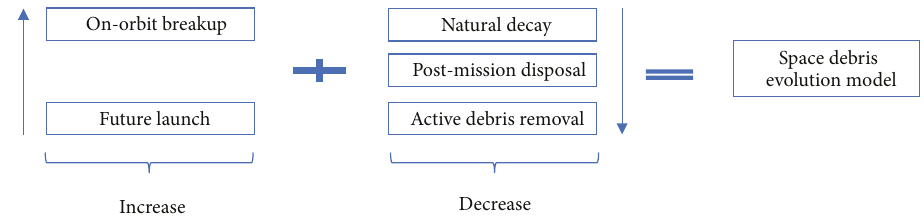
Figure 1: The general components of space debris evolution models. The left components are the main source mechanisms, and the right components are the main sink